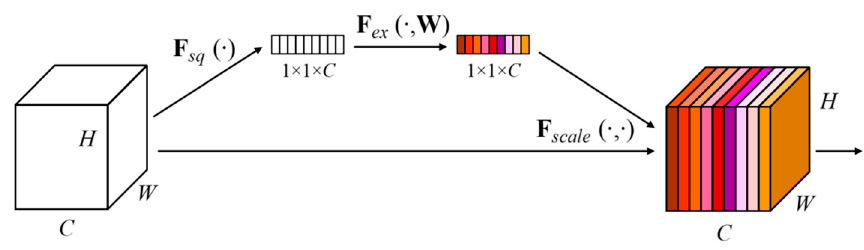
Figure 8. Schematic diagram of SENet block [34]. The size of the original feature map was H × W × C , where H is the height, W is the width, and C is the number of channels. Fsq (·) compressed the feature map from H × W × C to 1 × 1 × C ; then Fex (·, W ) learns the dependence of each channel and Fscale (·, ·) adjusts the feature map according to the dependence.